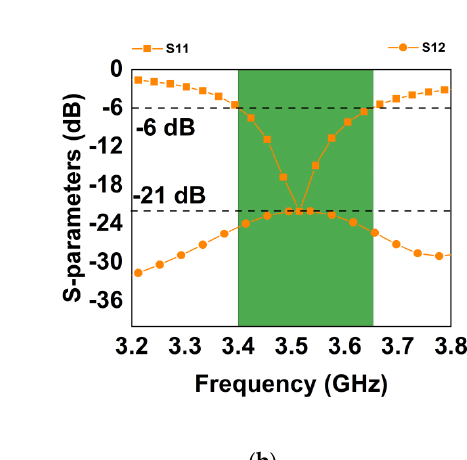
Figure 3. Antenna surface current distribution at 3.5 GHz with Ant.1 excited ( a ) with no decoupling element and ( b ) with the decoupling element.